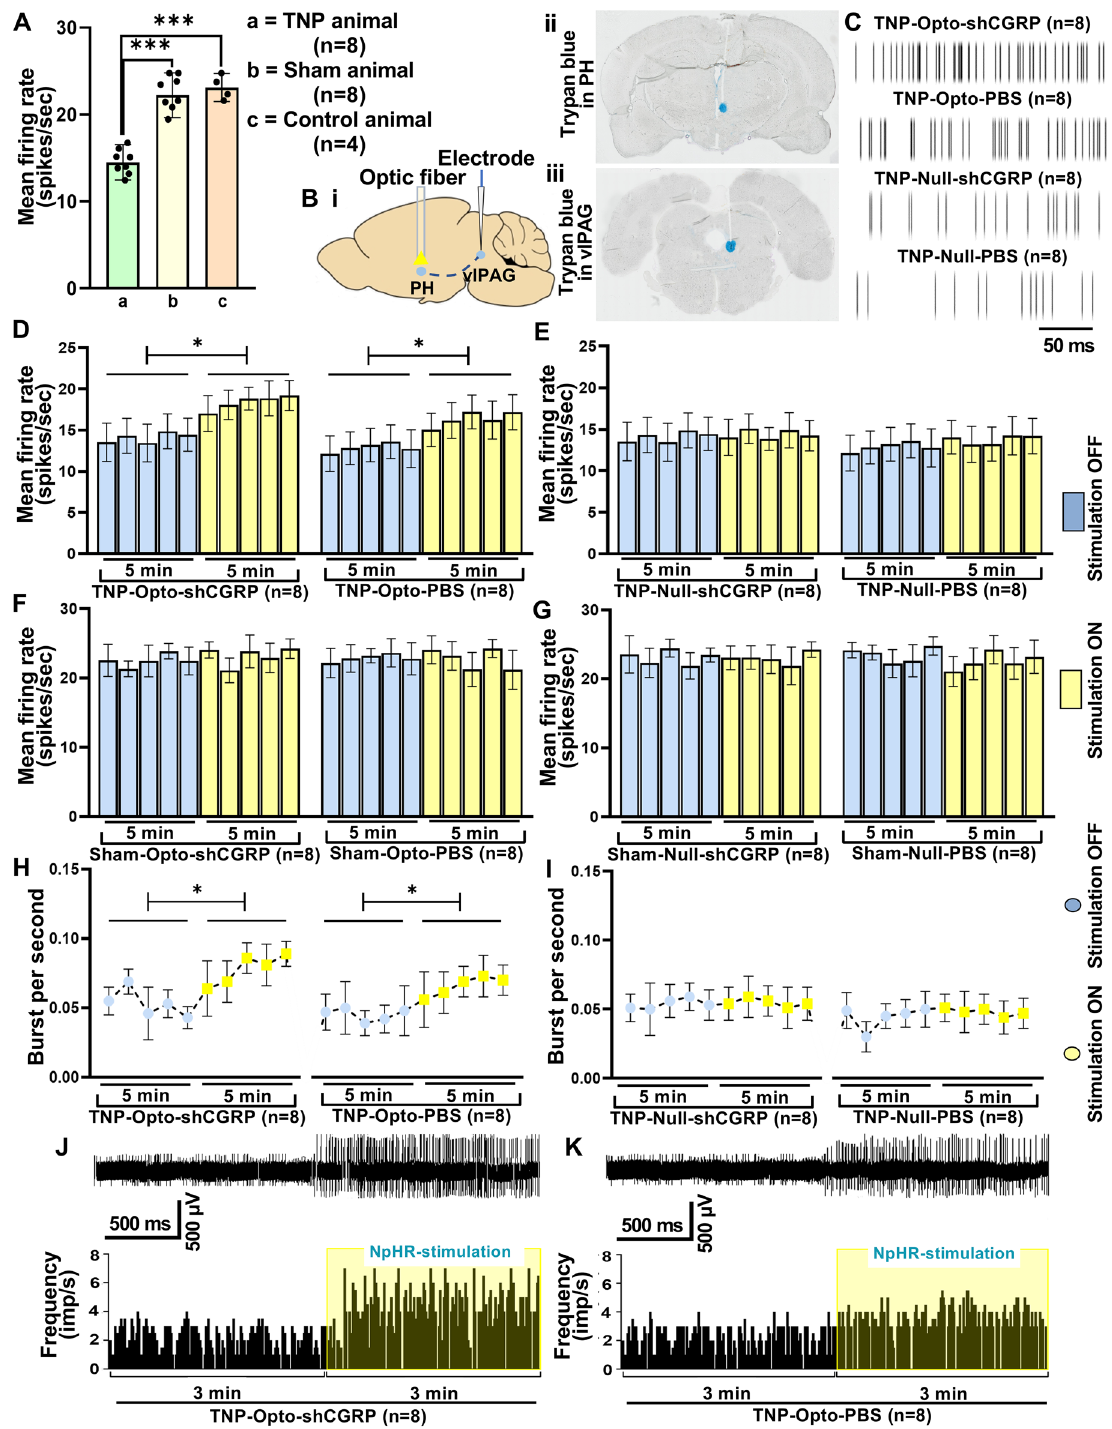
Figure 3. In vivo extracellular recording from the vlPAG. ( A ) Spontaneous firing rates of TNP ( n = 8) animals compared to sham ( n = 8) and control ( n = 4) animals (***, p < 0.001, unpaired t tests ). ( B ) Diagram showing the optogenetic inhibition and extracellular recording areas (i), trypan blue confirming the optic fiber tip position in the PH (ii) and the electrode tip position in the vlPAG (iii). ( C ) Recorded representative raster traces of the time calibration of 50 ms from the vlPAG of the TNP-Opto (n = 16) and TNP-Null (n = 16) groups. ( D – G ) Spontaneous neural firing rates of the vlPAG in the TNP-Opto (n = 16) (D), TNP-Null (n = 16) ( E ), Sham-Opto (n = 16) ( F ), and Sham-Null (n = 16) ( G ) groups. ( H , I ) Burst firing rates of the vlPAG in the TNP-Opto (n = 16) ( H ) and TNP-Null (n = 16) ( I ) groups. ( J , K ) Representative example of the increase in instantaneous firing frequency caused by optic stimulation in the TNP-Opto-shCGRP (n = 8) ( J ) and TNP-Opto-PBS (n = 8) ( K )